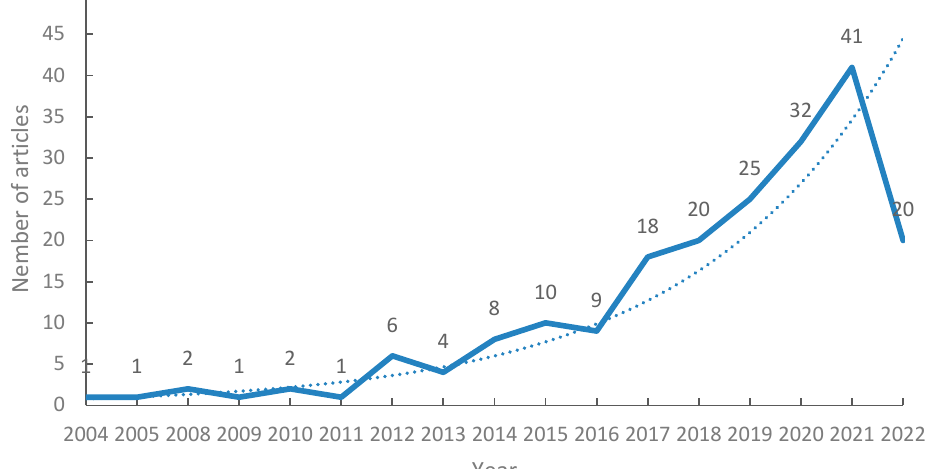
Figure 2. Publication trends over time.